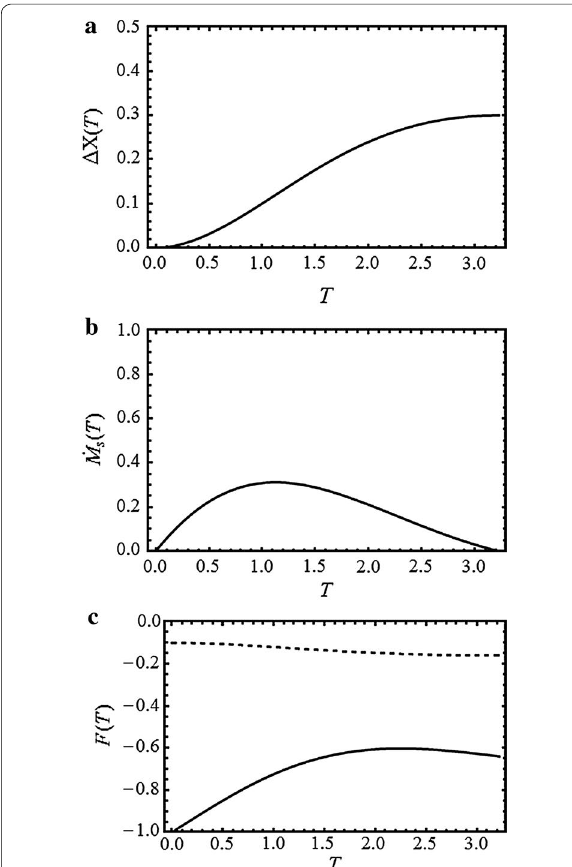
Fig. 4 Seismic slip. The graphs show a the slip amplitude (cid:31) X ; b the associated moment rate M s ; c the forces F 1 (solid) and F 2 (dashed) on the asperity and on the weak region, respectively, as functions of nondimensional time T